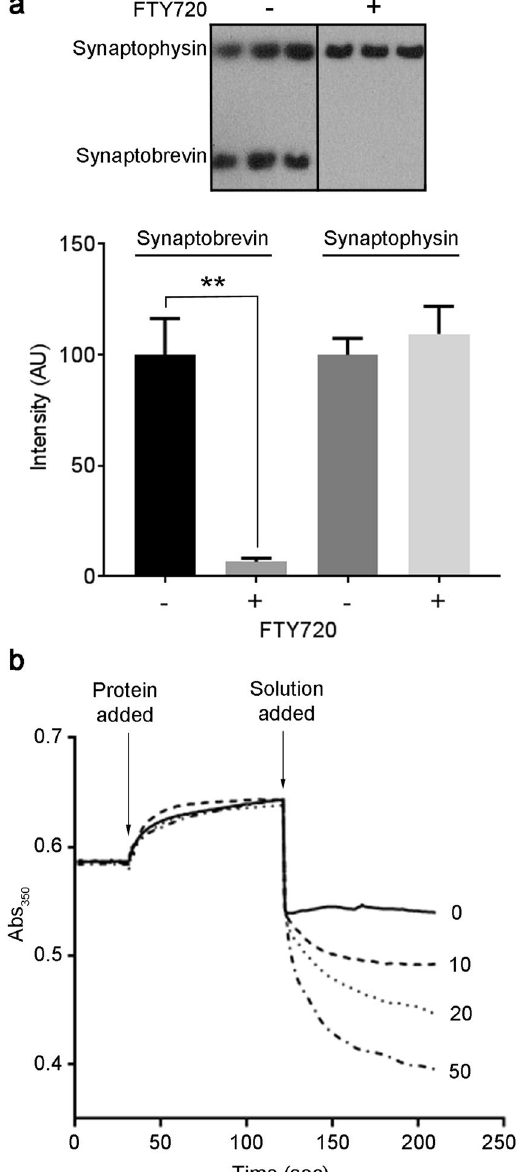
Figure 6. FTY720 disrupts the interaction of the cytosolic part of synaptobrevin with phospholipid membranes. ( a ) Immunoblot showing that native synaptobrevin in rat brain synaptic vesicles (5 µ g protein) exhibits faster degradation by GluC protease (2.5 ng/ µ l) in the presence of FTY720 (50 µ M). Synaptophysin immunostaining indicates no change in its proteolytic degradation suggesting a specific action of FTY720 on synaptobrevin ( ** P < 0.005, ANOVA, n = 3). ( b ) Graph showing that addition of dimeric GST-synaptobrevin (aa 1–96) causes aggregation of phospholipid liposomes as evidenced by a gradual increase of absorbance at 350 nm (Abs 350 ). The aggregated state can be reversed by the addition of FTY720 solution at the indicated concentrations. In the absence of FTY720, only a drop due to the dilution factor is